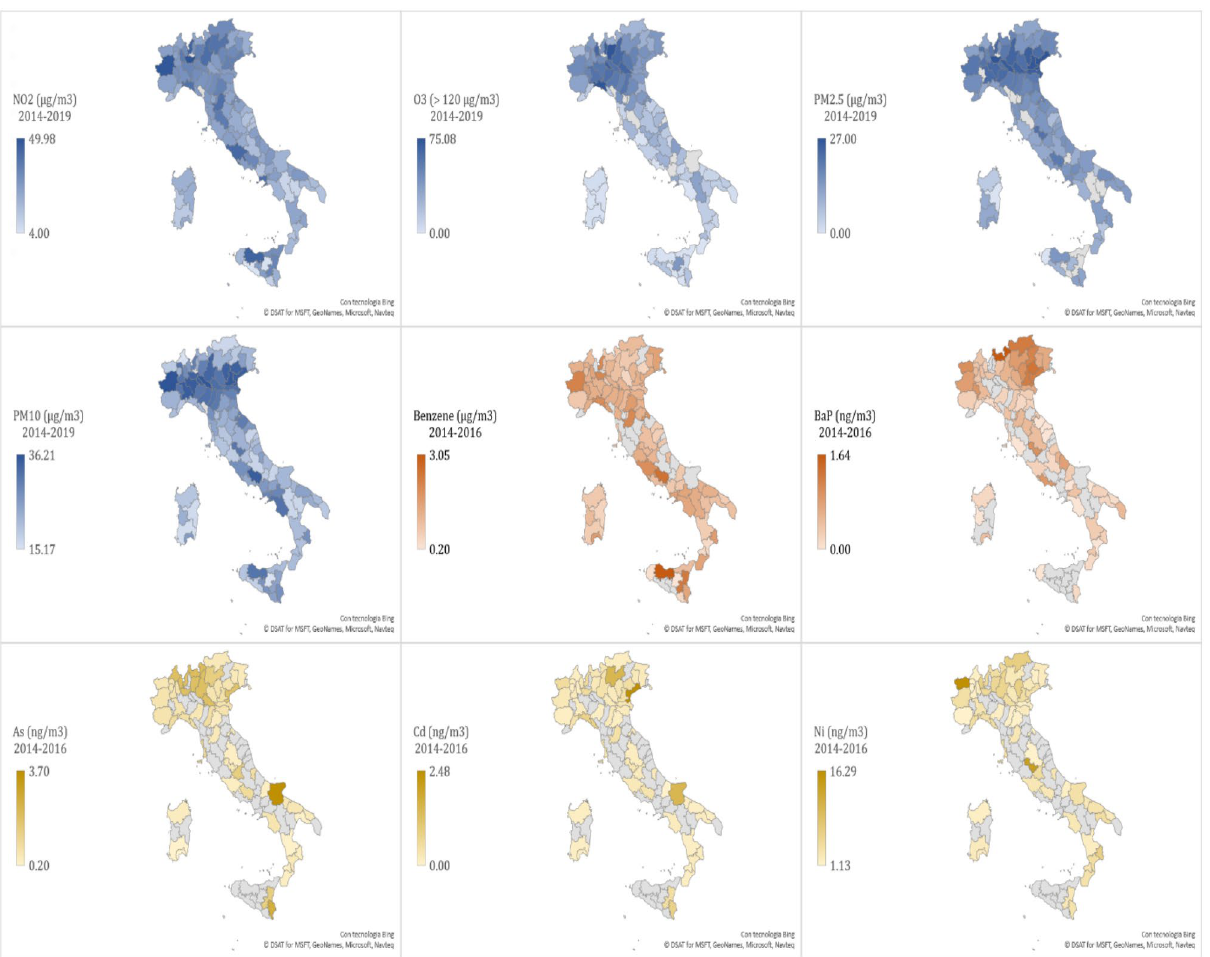
Figure 1. Average long-term outdoor concentrations (or violations) of NO 2 , O 3 , PM 2.5 , PM 10 , benzene, BaP, As, Cd, and Ni, in the 107 Italian provinces. When no data are available, the province is grey colored. The map was generated using Microsoft Excel software 2021. All the sources used to collect the data are reported in detail in the Appendix